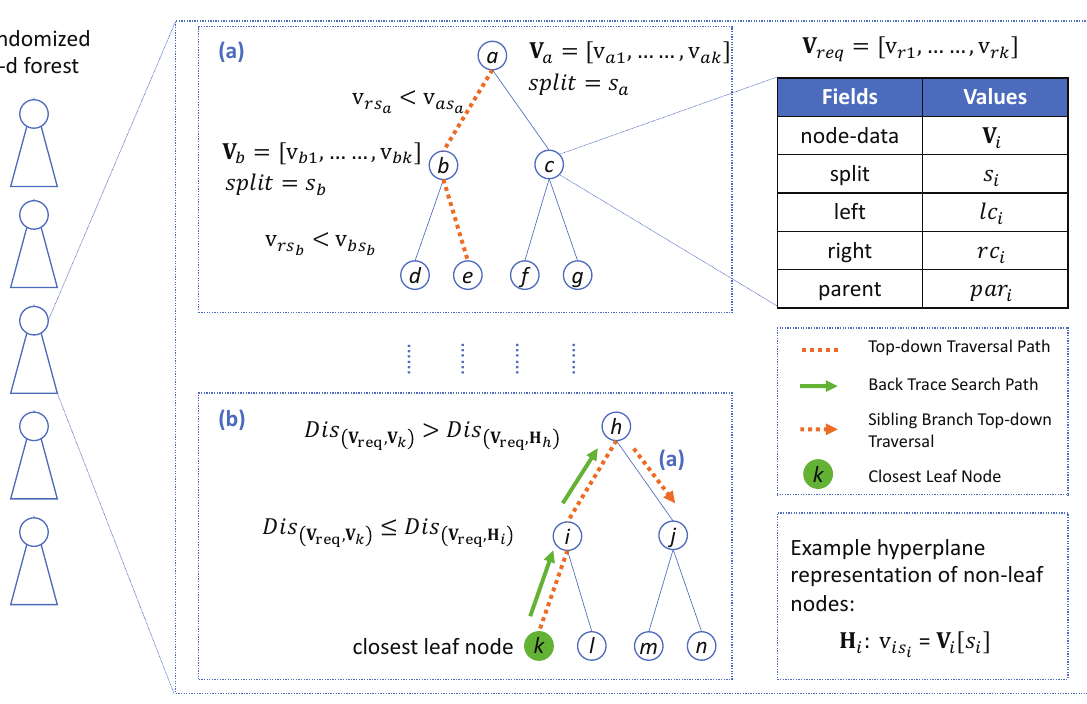
is stored in each tree node i . Dis ( · ) is an arbitrary distance calculation function i and Node ’s hyperplane. V is the least closest vector to V req i qL